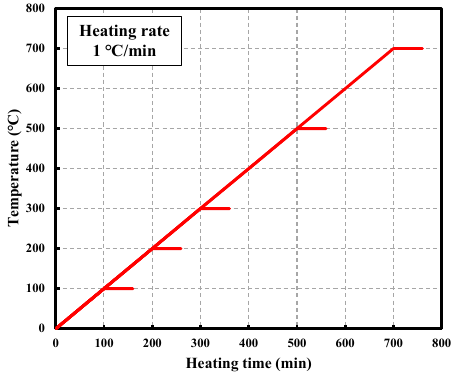
Figure 4. Heating curves.